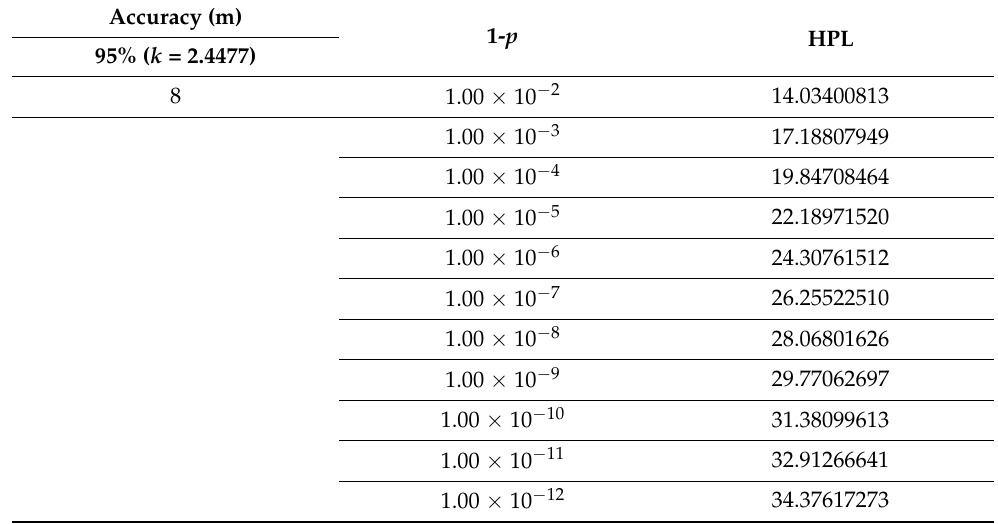
Table 5. Dependence of HPL specified for 8 m 95% accuracy on its probability level p